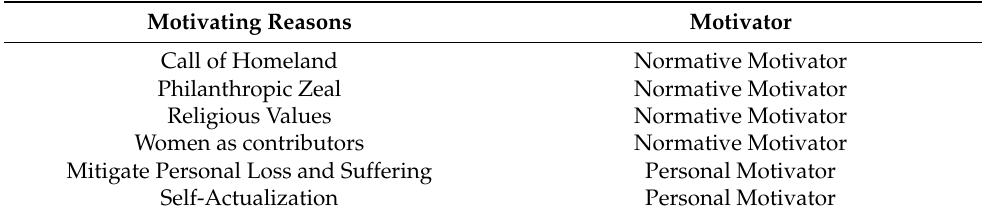
Table 2. Motivating reasons and motivators of women